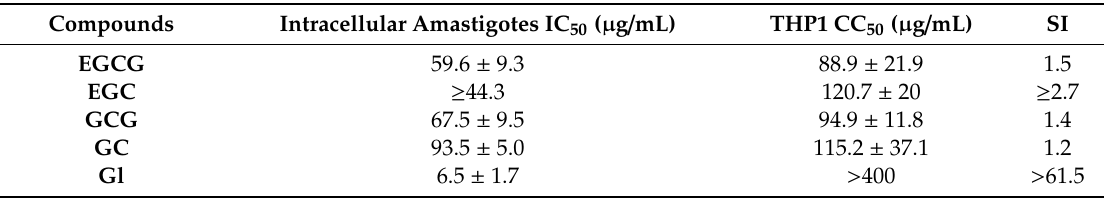
IC 50 : inhibitory concentration for 50% of parasites; CC 50 : cytotoxic concentration for 50% of cells; SI: selectivity index obtained from ratio CC 50 THP1 / IC 50 Leishmania . Results represent the mean ± standard deviation of